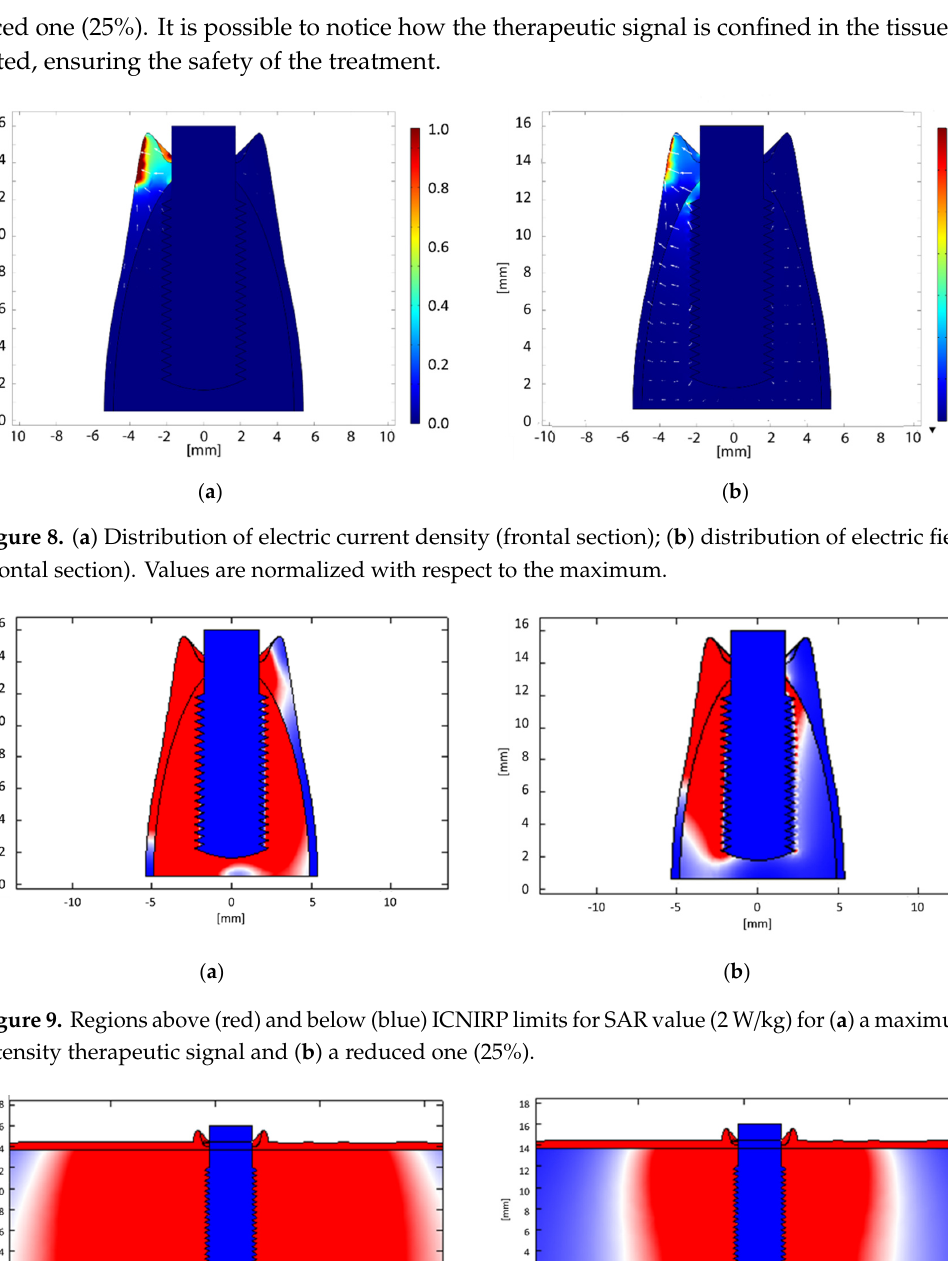
Figure 8. ( a ) Distribution of electric current density (frontal section); ( b ) distribution of electric field (frontal section). Values are normalized with respect to the maximum.